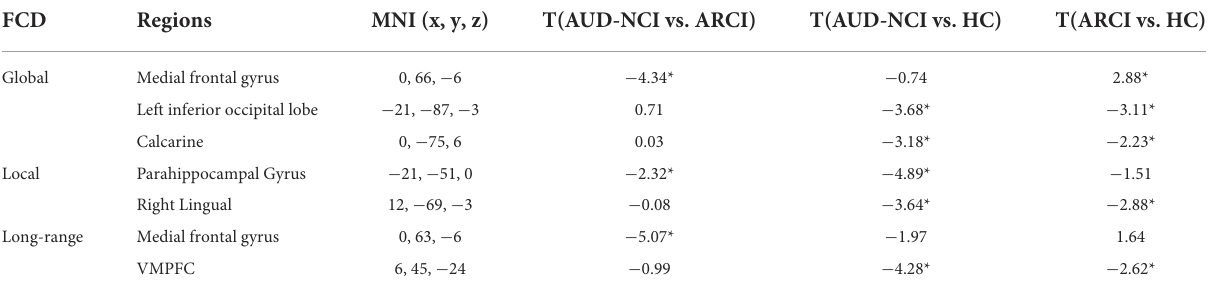
TABLE 3 Post-hoc analysis